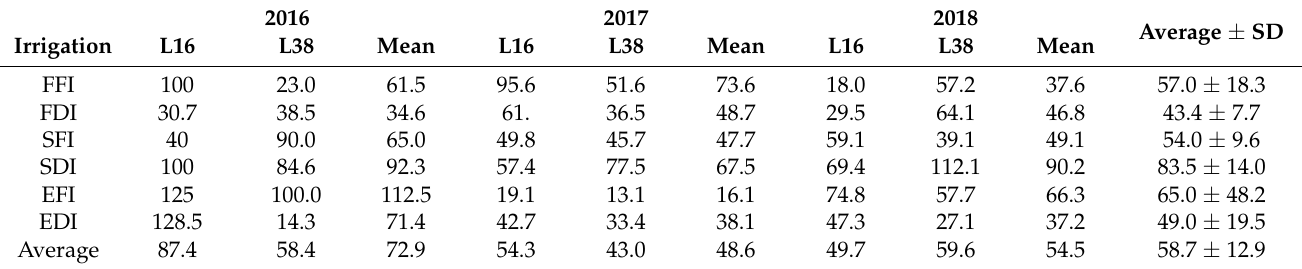
Table 2. Percentage changes of cotton yield with respect to NT in each irrigation